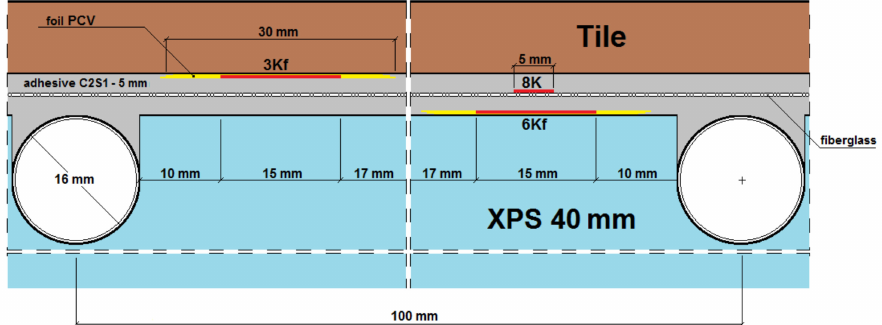
Figure 8. Vertical section II–II of the research model with C2S1 adhesive, without lamellas.